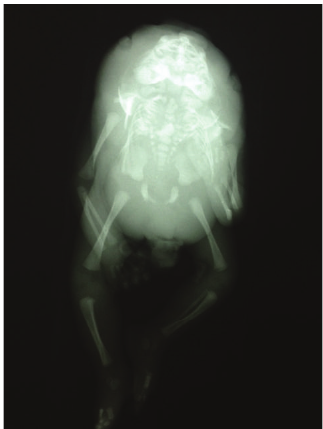
Figure 2: Radiological image of the